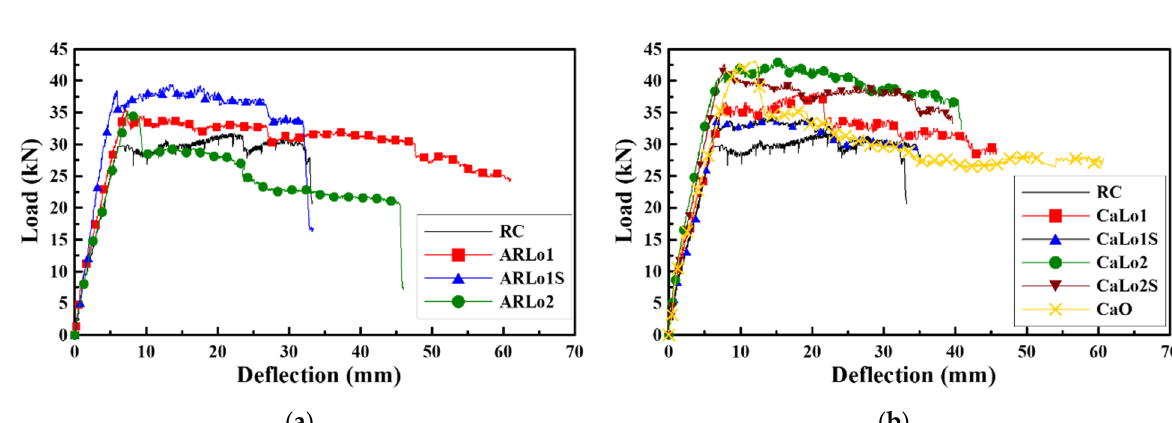
Figure 3. Load and deflection curves: ( a ) AR-glass TRM; ( b ) Carbon TRM.